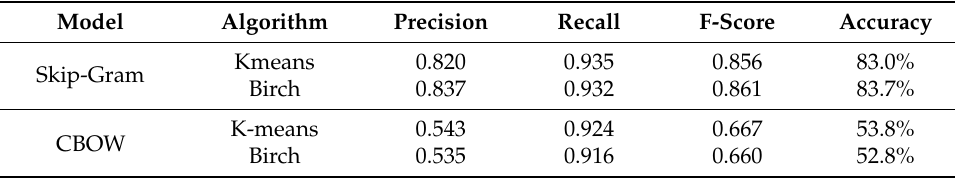
Table 5. Summary for clustering algorithms with entity embedding model on test